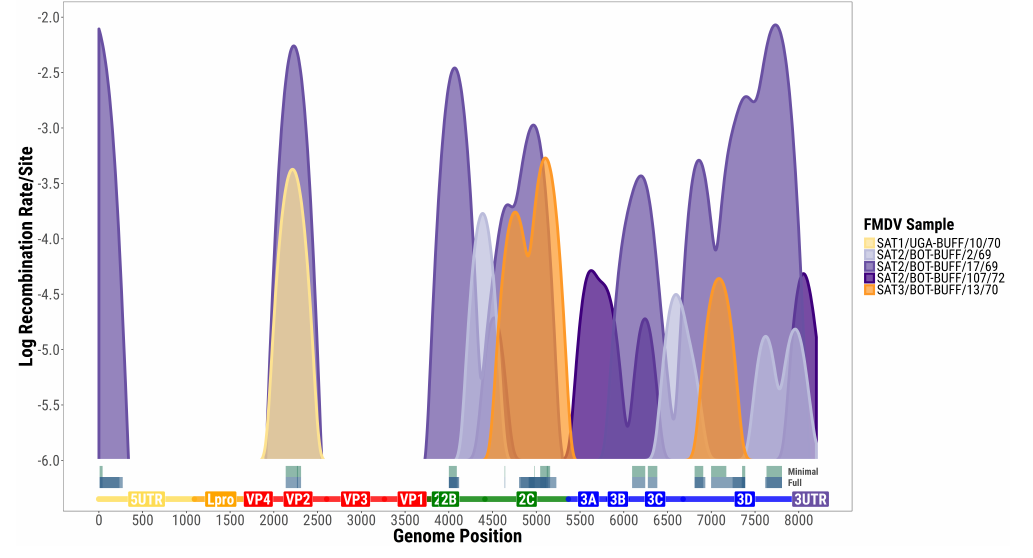
Figure 2. Foot-and-mouth disease virus (FMDV) recombination rates inferred from each sample. Samples are coloured according to their serotype and the corresponding rates are smoothed via a Gaussian kernel with a width of 200 bases. The grey intervals at the bottom illustrate the minimal recombination intervals ( top ) and the full set of recombining pairs of Single Nucleotide Polymorphisms (SNPs) ( bottom